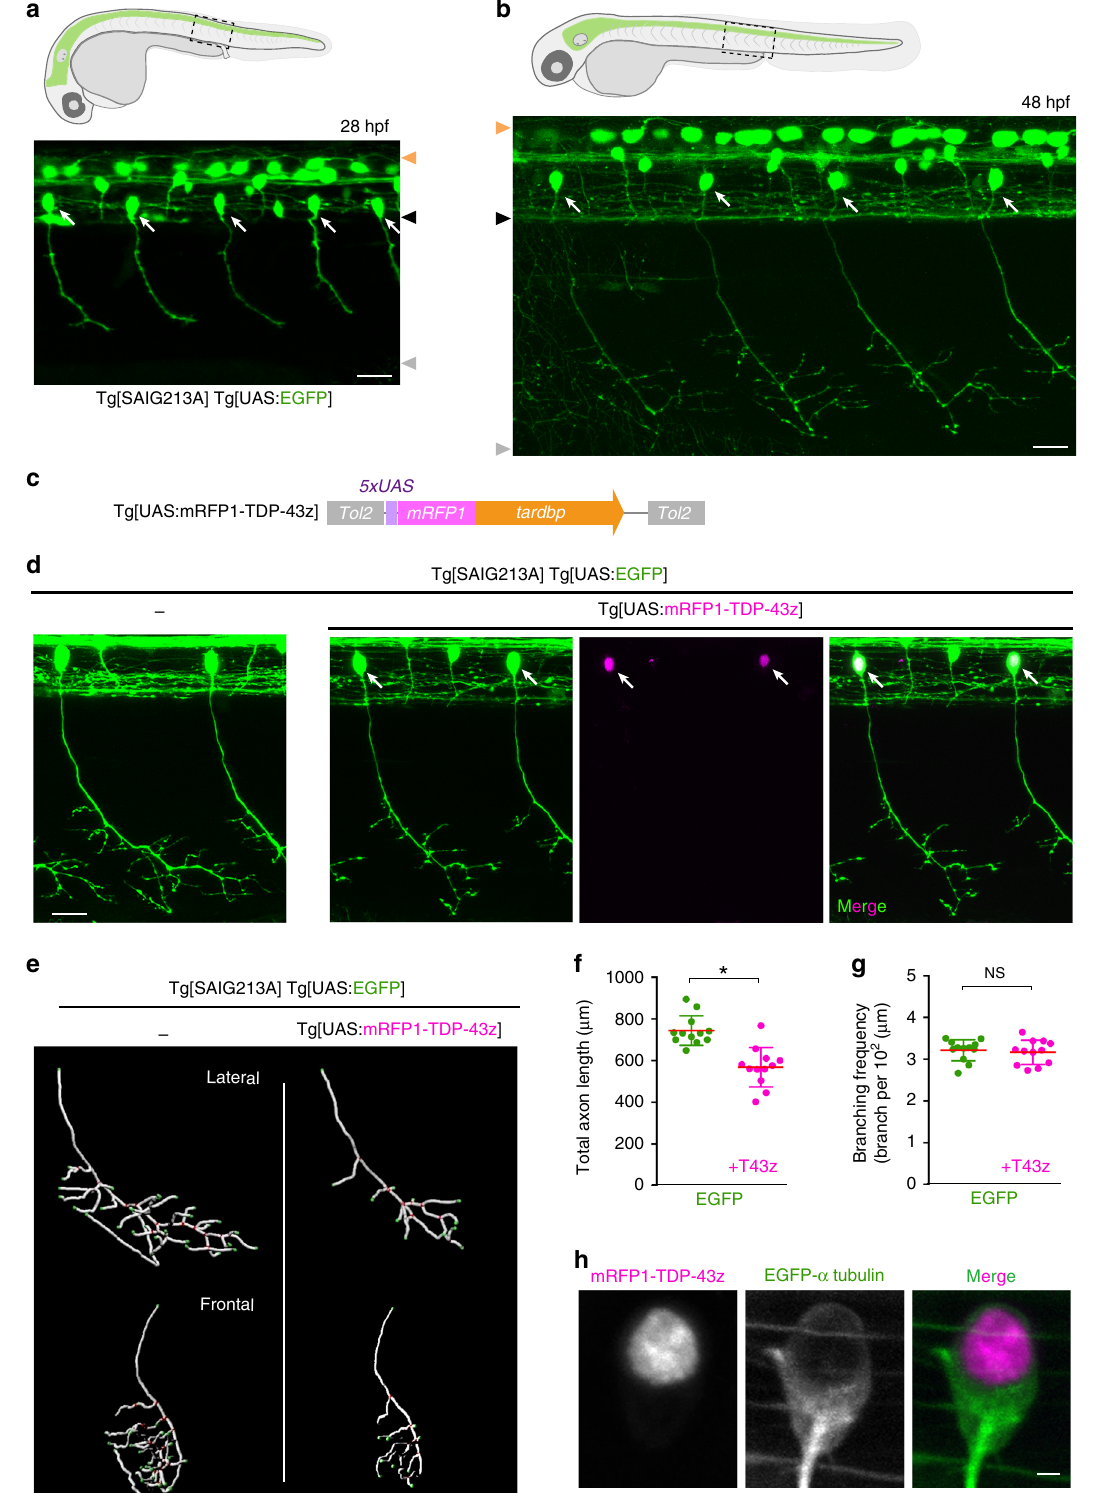
opTDP-43z is functional. Since the strong whole-body expression of mRFP-TDP-43z driven by Tg[SAGFF73A] driver perturbed development (Supplementary Fig. 2), we generated a UAS transgenic line that expressed a tolerable level of opTDP-43z in combination with Tg[SAGFF73A] driver (Fig. 2a; Tg[UAS: opTDP-43z]). In Tg[SAGFF73A] Tg[UAS:opTDP-43z]